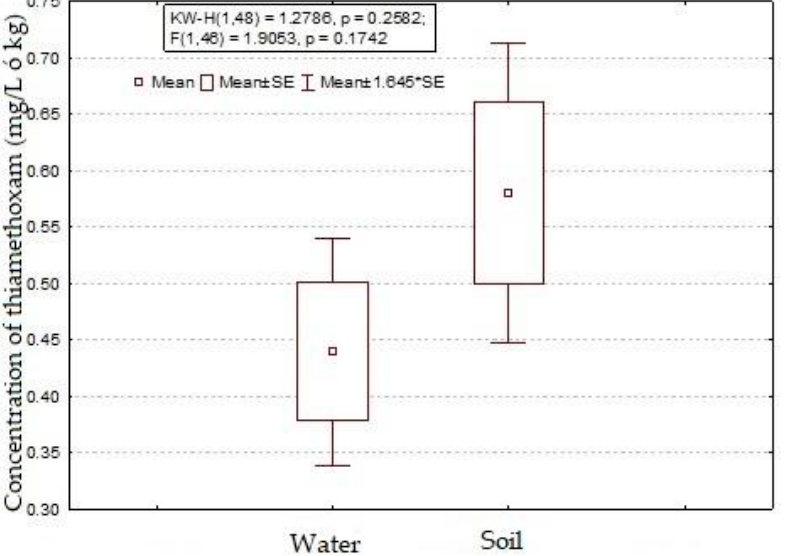
Figure 2. Concentration of thiamethoxam in irrigation water (mg / L) and soil (mg / kg) in a papaya crop rotation with watermelon in the area of Cotaxtla,